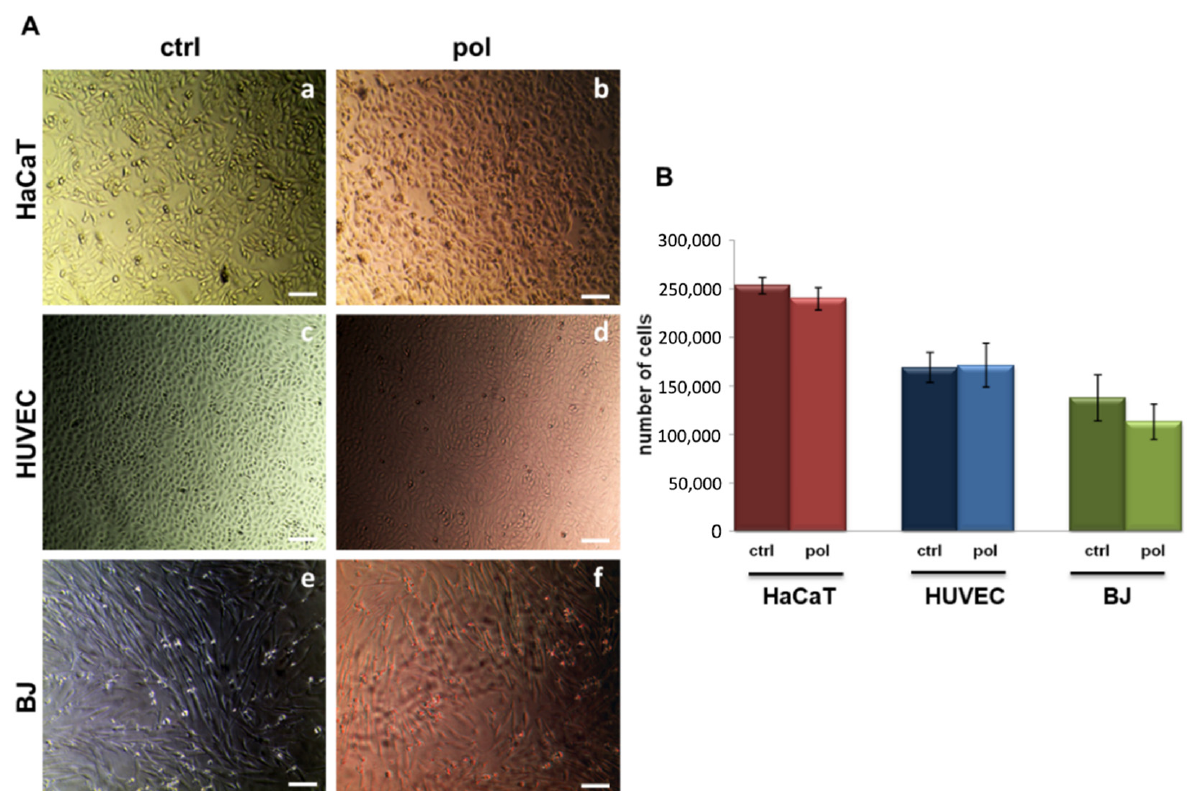
Figure 5. ( A ) Representative images of HaCaT (panels ( a ) and ( b )), HUVEC (panels ( c ) and ( d )), and BJ cells (panels ( e ) and ( f )) and ( B ) hemocytometer cell counts of the same cells at 72 h after seeding on the coverslips with (pol) or without (ctrl) the polymer coating. Magnification 10 × . Bar = 100 µ m. The data represent the mean of three experiments performed on P4VP-ZnNB 20% w / w thin films in triplicate with similar results.